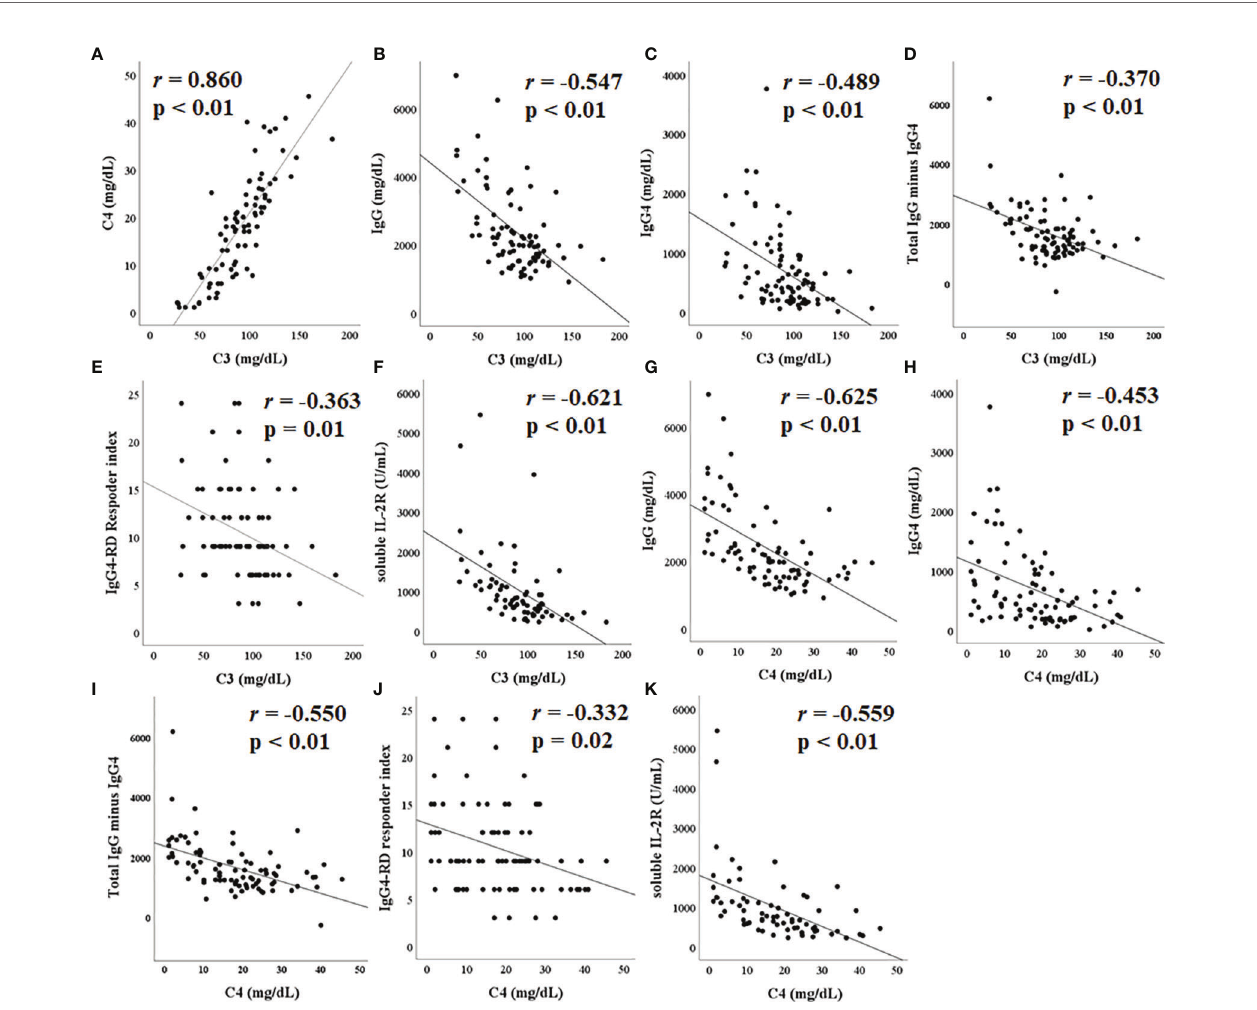
FIGURE 2 | Correlation between complement C3/C4 and other laboratory tests. C3 levels positively correlated with C4 (A) . C3 levels negatively correlated with immunoglobulin (IgG) (B) , IgG4 (C) , total IgG minus IgG4 (D) , immunoglobulin G4-related disease (IgG4-RD) responder index (E) , and soluble IL-2R (F) , all signi fi cantly. Similarly, C3 levels showed a signi fi cant negative correlation with IgG (G) , IgG4 (H) , total IgG minus IgG4 (I) , IgG4-RD responder index (J) , and soluble IL-2R (K)